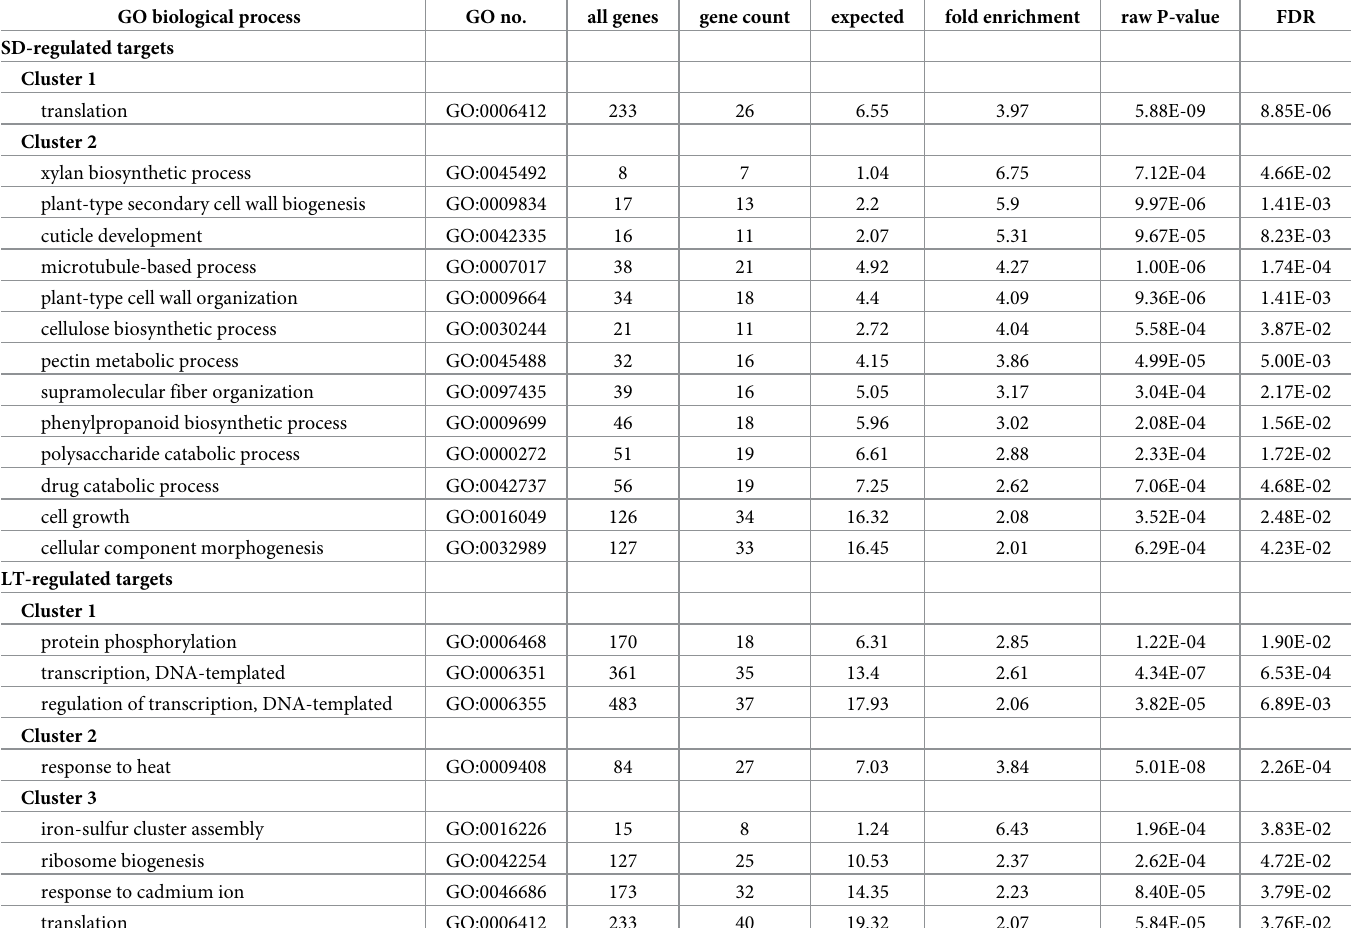
Table 3. Functional categories overrepresented in a cluster of targets regulated by day length and